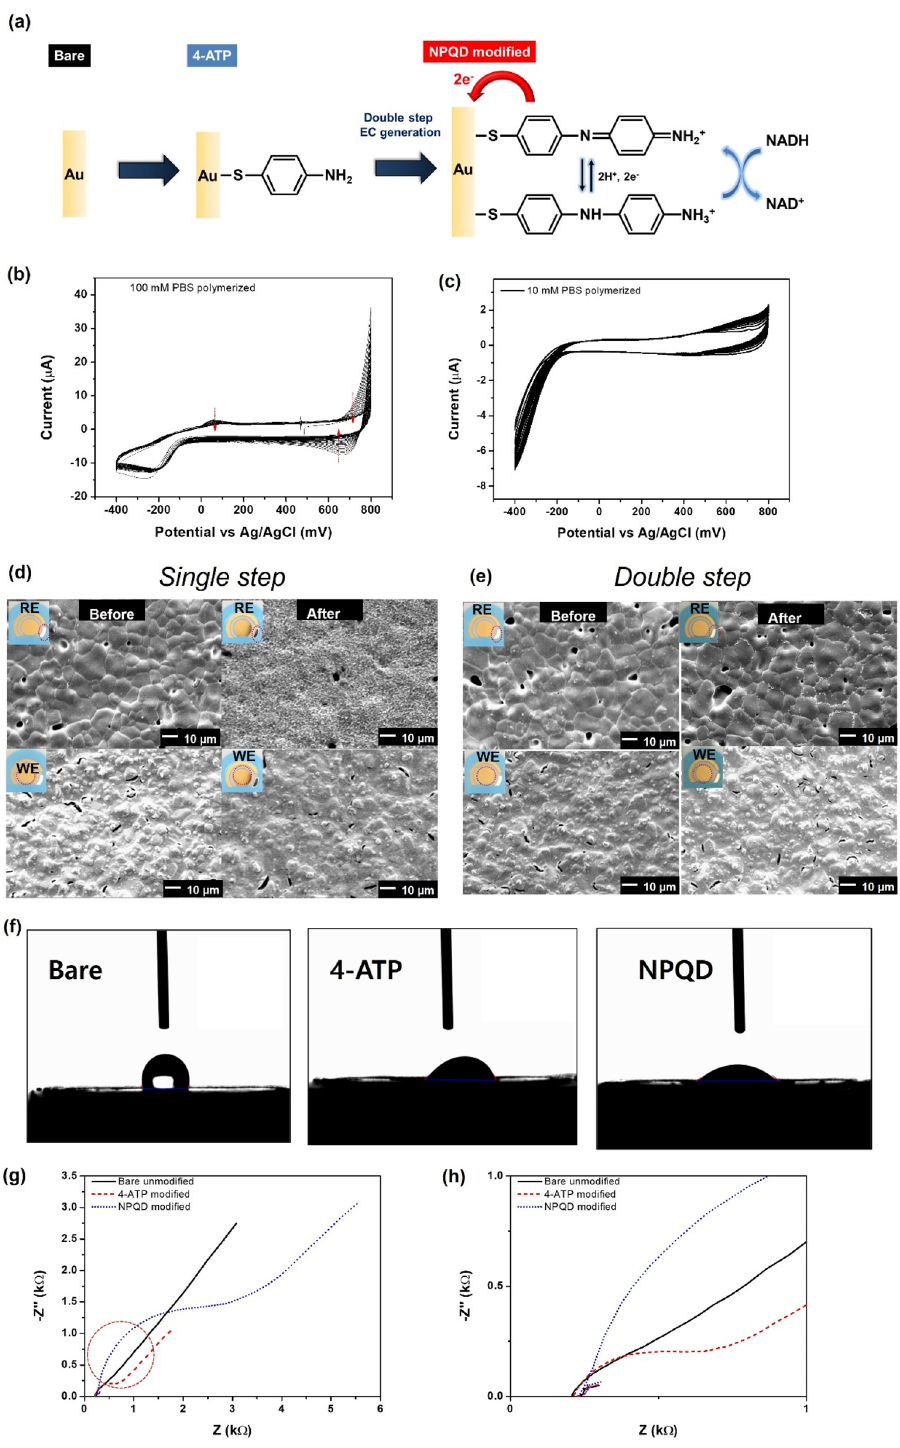
Figure 1. ( a ) Schematic diagram of NPQD modification. ( b , c ) CV data obtained during the electrochemical functionalization of the 4-ATP Au electrode in ( b ) 100 mM PBS (pH 7.4) and ( c ) 10 mM PBS (pH 7.4) after ( b ). The scan rate is 100 mV/s. ( d , e ) Single-step and double-step SEM images of the SPE surface after NADH measurement (five times) by changing the surface modification method. The reference and working electrodes are denoted by RE and WE. ( f ) Contact angle measurement of each electrode. ( g ) Nyquist plot for each electrode. EIS was performed in a 5 mM K 3 Fe(CN) 6 + 0.1 M KCl solution. ( h ) The large graph is the expansion from the circled part of the Nyquist plot of ( g